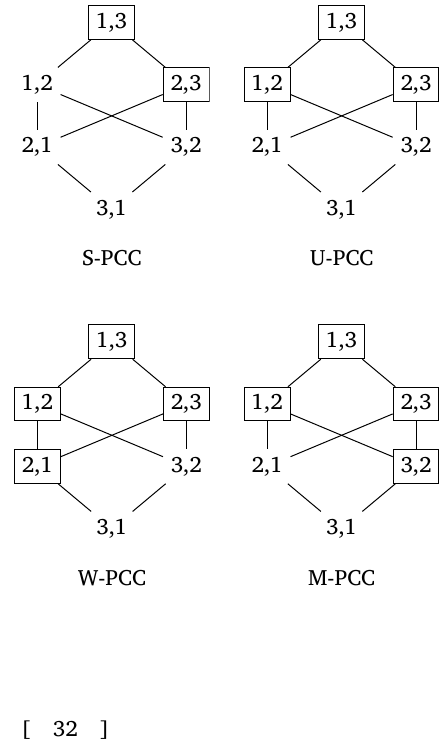
The four PCC variants as monotonic maps from the person hierarchy to the algebra of truth values; boxed nodes are mapped to true, all others to false